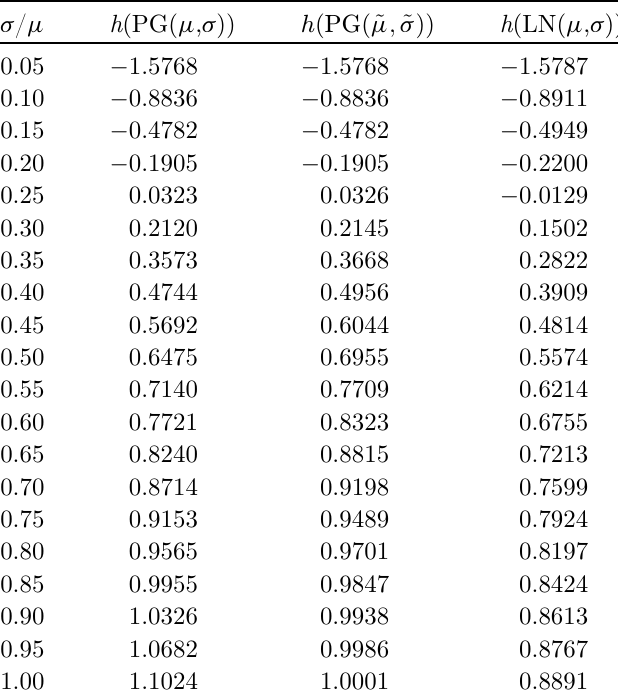
Table 3. Entropy values for several